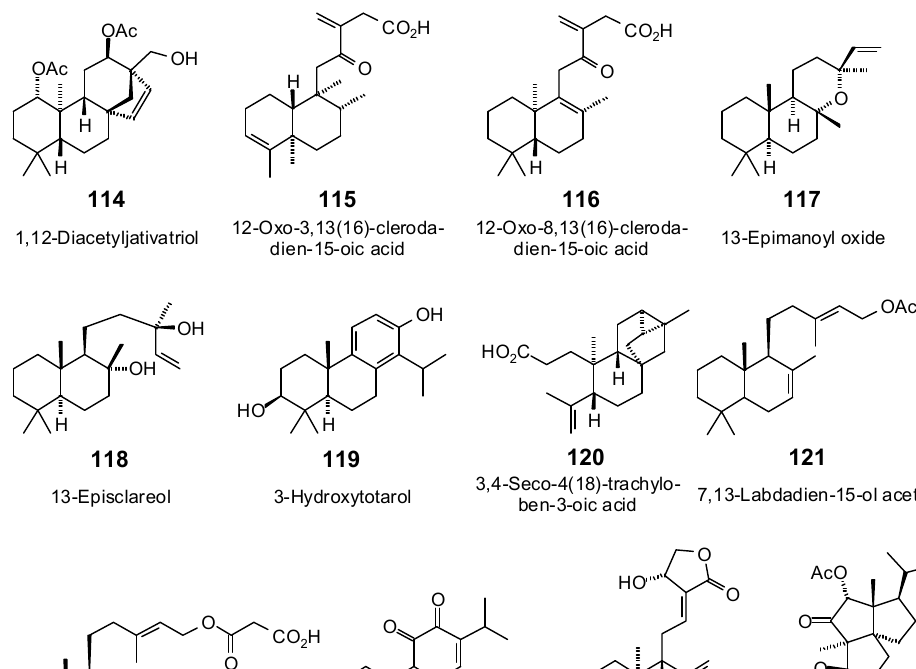
Figure 6. Sesquiterpenoids examined in this work.